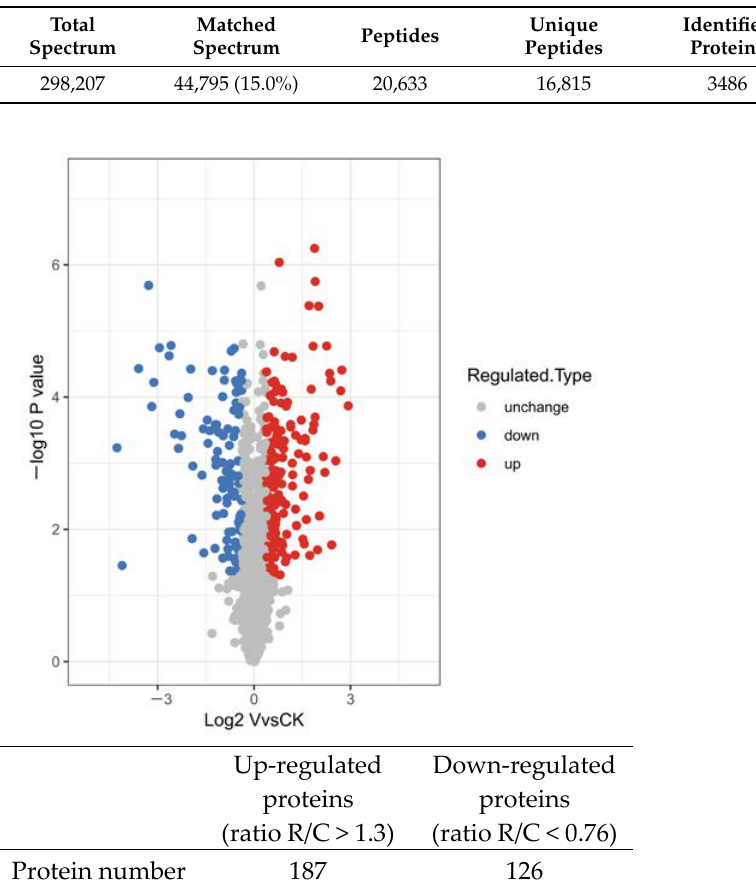
Figure 2. The volcano plot of the DEPs showing both up-regulated (red) and down-regulated (blue) proteins.